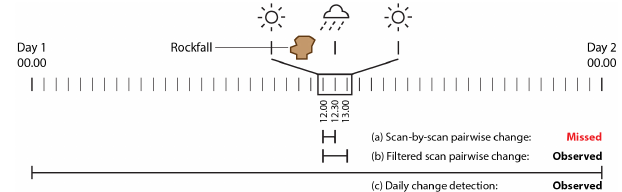
Figure 4. Conceptual illustration of the significance of removing partial scans. While parts of these scans provide accurate estimates of surface change, if a rockfall occurs in an area of no data, the failure will be missed using pairwise change. These scans should therefore be removed prior to change detection of the scan